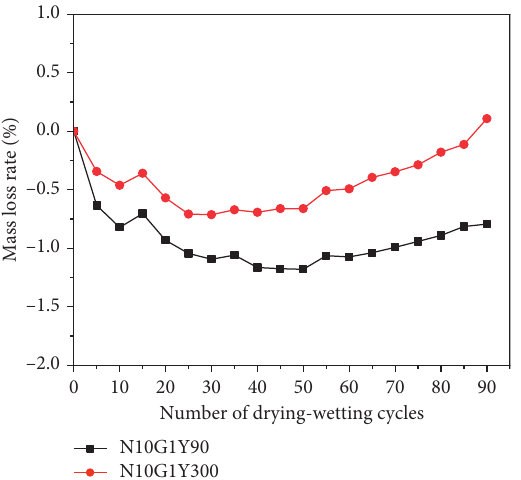
Figure 6: Variation of the mass loss rate of concrete with increasing curing time.